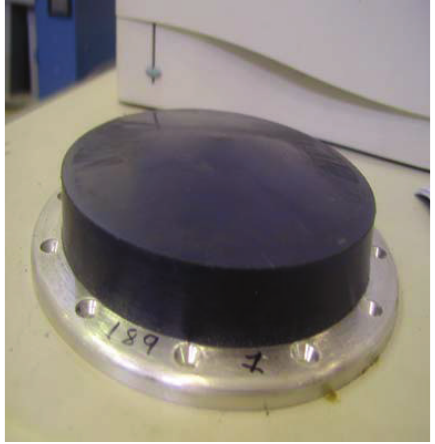
Figure 7: The plastic elastomer on the